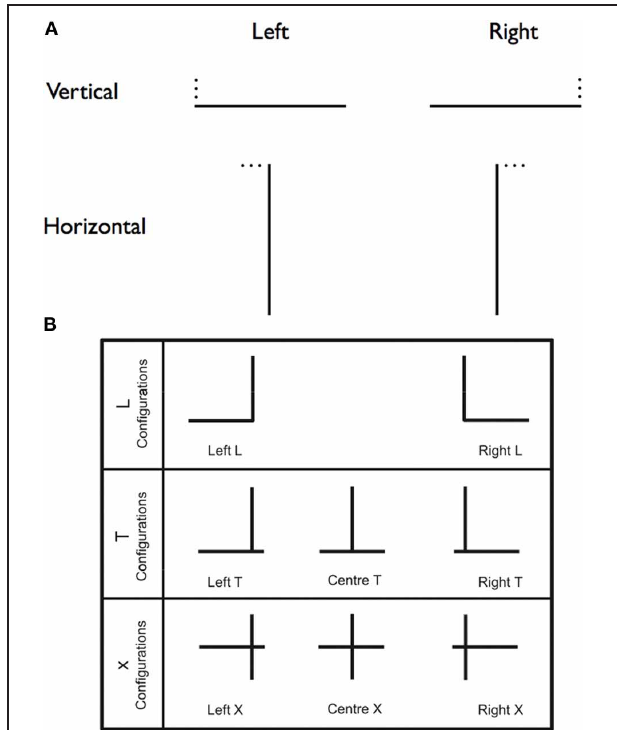
FIGURE 3 | Neglect and length estimation. (A) A schematic depiction of the stimuli used by Charras et al. (2010). A single black line, either horizontal or vertical (40mm long, 1mm thick), was printed in the center of the sheet. Participants performed a line extension task in which they were to draw either a horizontal or a vertical line to complete an L figure. The missing line was located either to the left or right of the presented line. The position of the missing line was indicated by three small black dots. (B) Schematic depiction of the stimuli used by Charras et al. (2012). The L configurations enabled to test leftwards and rightrightwards biases separately. In the T and X configurations, there was a left/right competition between the horizontal line segments left and right of the bisection line. The results showed that, in the T configuration, the vertical line was overestimated, while in the X configuration, the horizontal line was